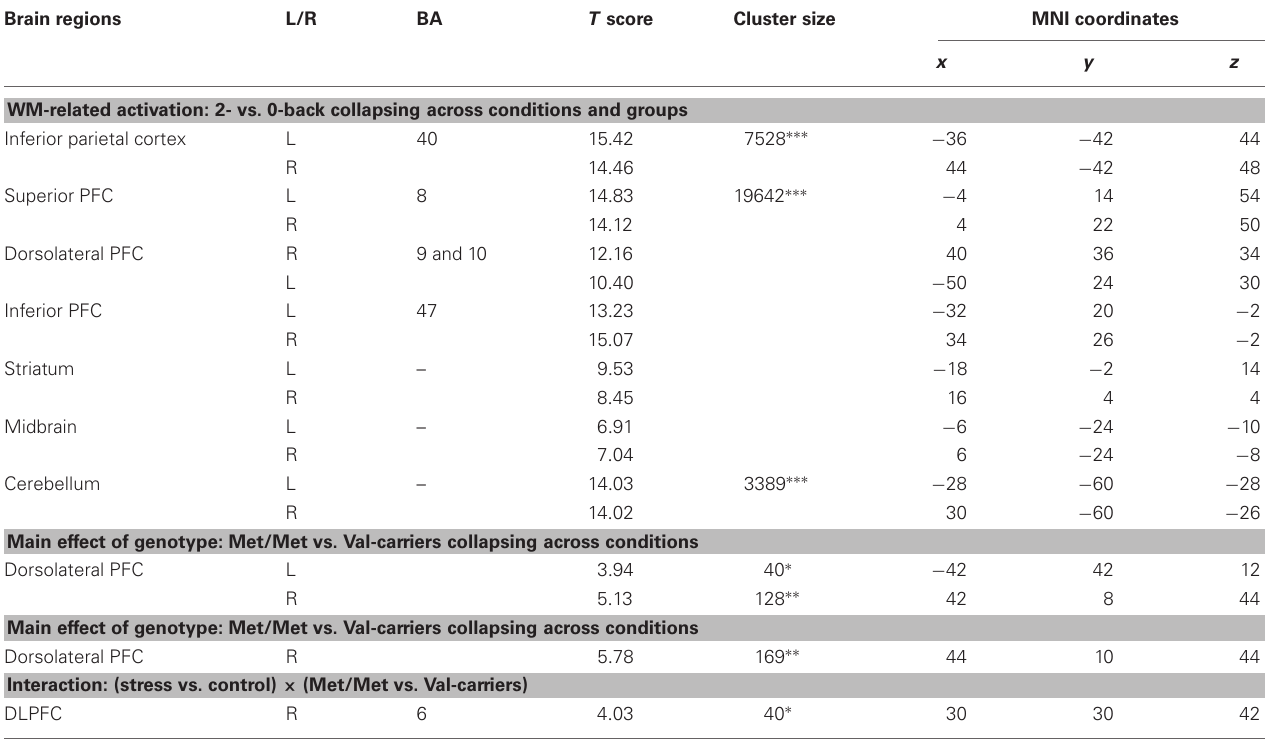
Table 4 | Brain activations related to WM, and modulations of stress and COMT genotype. Brain